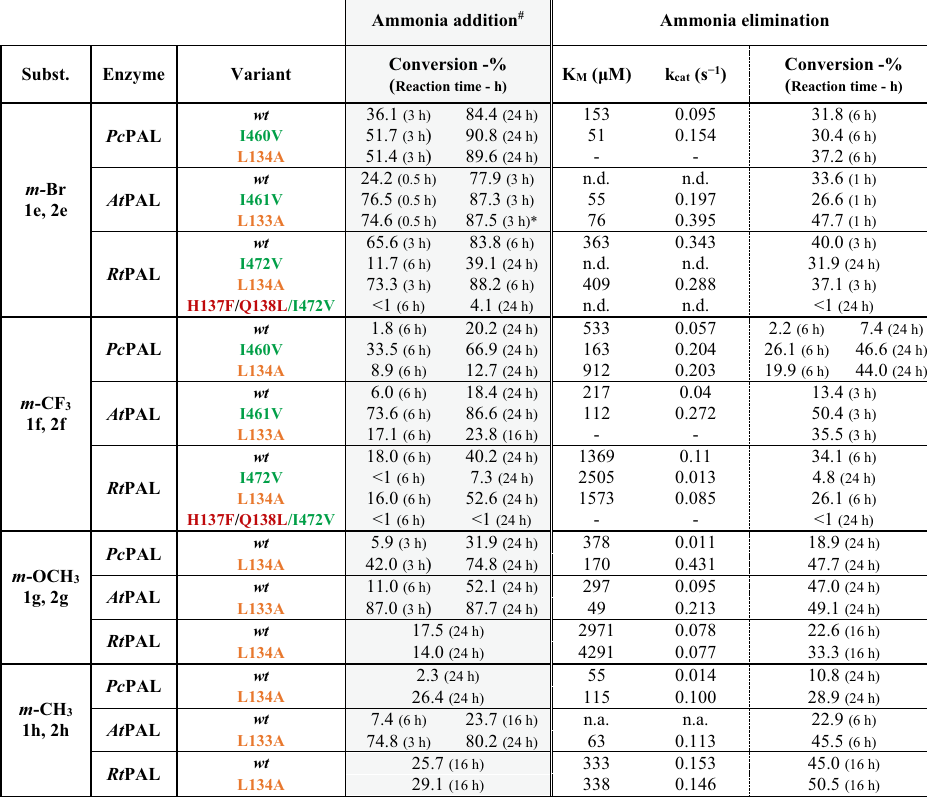
Table 2. Activity assessment of the different PAL variants within the ammonia addition and ammonia elimination reactions of meta -substituted cinnamic acids 2e – h and rac -phenylalanines 1e – h , respectively. n.d. not determinable, during enzyme kinetics the non-linear range of the Michaelis–Menten curve was not obtained using substrate concentration allowed by the solubility of the tested compounds. n.a. no activity detected. “–” no determination/measurement was performed. # During the ammonia additions the enantiomeric excess of